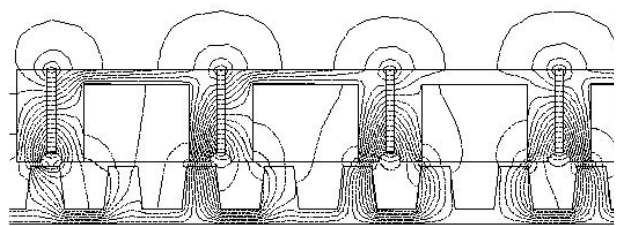
Figure 5. No-load magnetic field distribution of Machine III.